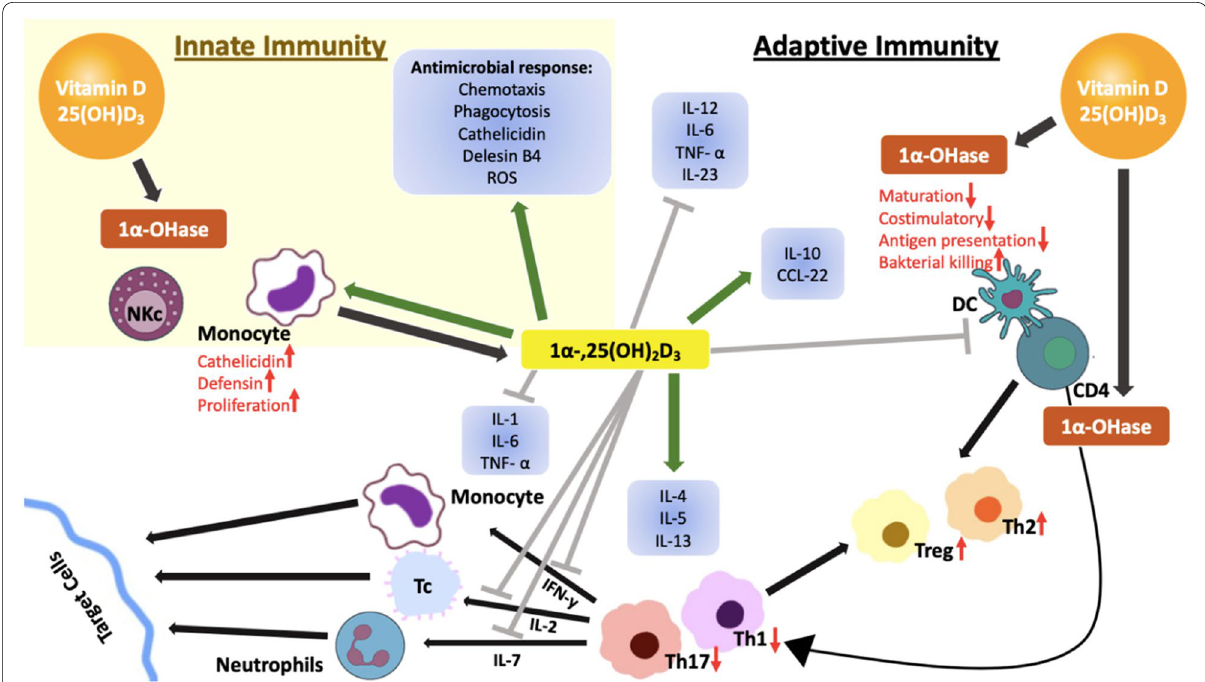
Fig. 1 Effects of 1,25(OH) 2 D on innate and adaptive